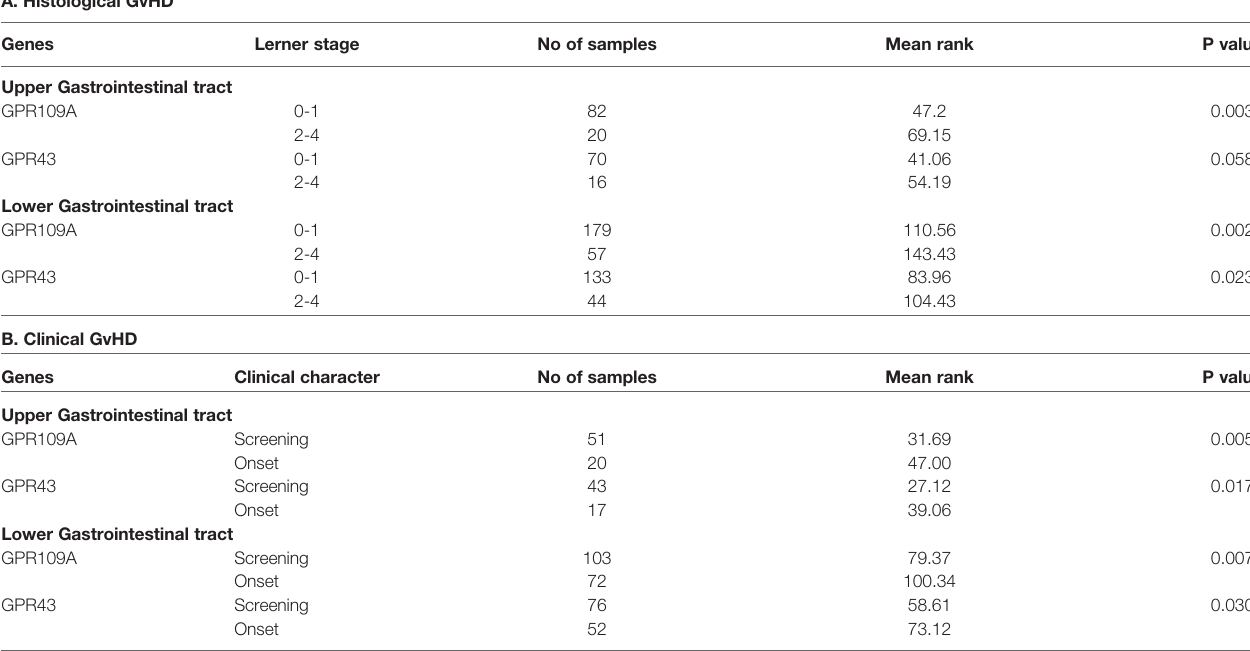
TABLE 1 | Distribution of GPR109A and GPR43 in the upper and lower gastro-intestinal (GI) tract.